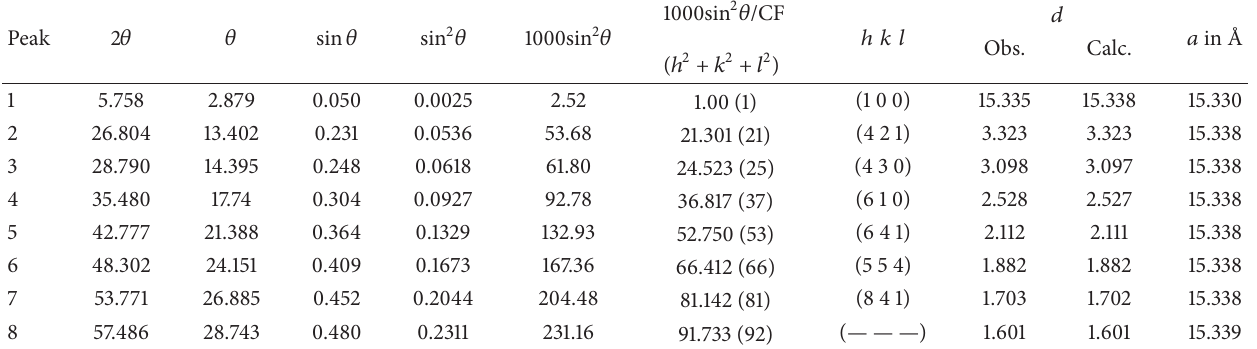
Table 5: Powder X-ray data of Cu(II) complex.